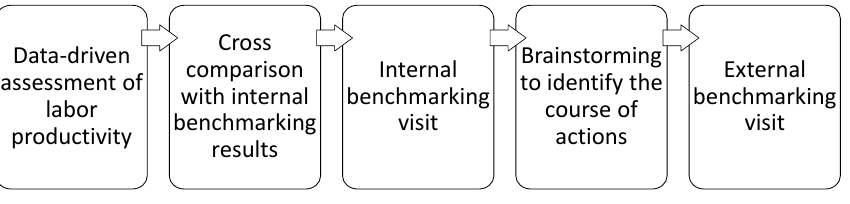
Figure 9. Solution process to close the competitiveness